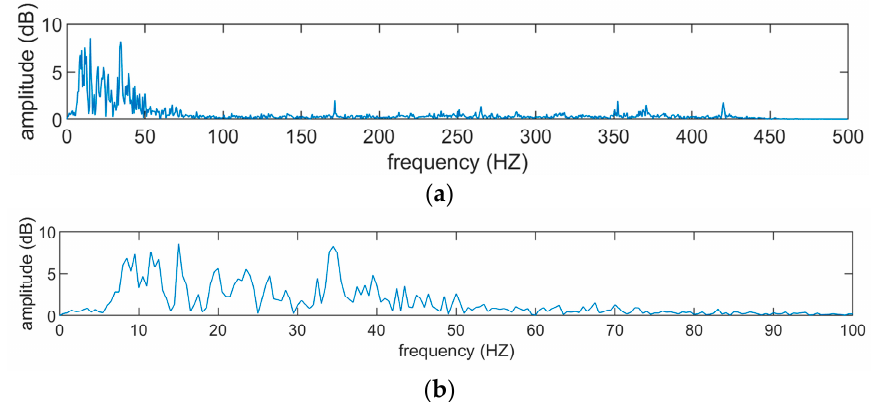
Figure 9. Frequency spectrum of the actual micro-seismic data. ( a ) Overall frequency spectrum. ( b ) Part of the frequency spectrum.